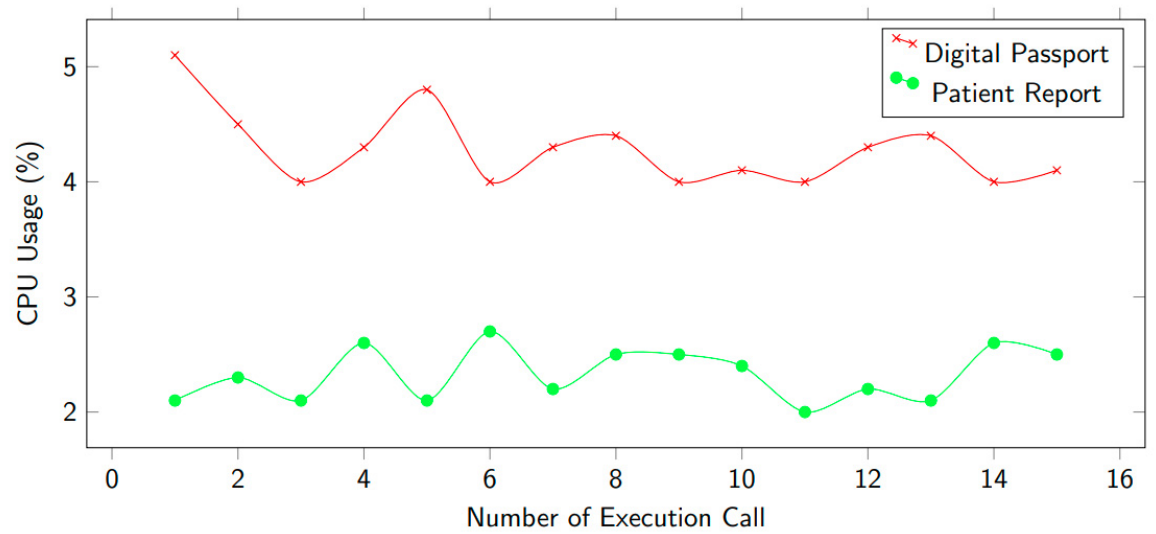
Figure 14. CPU consumption computation time.